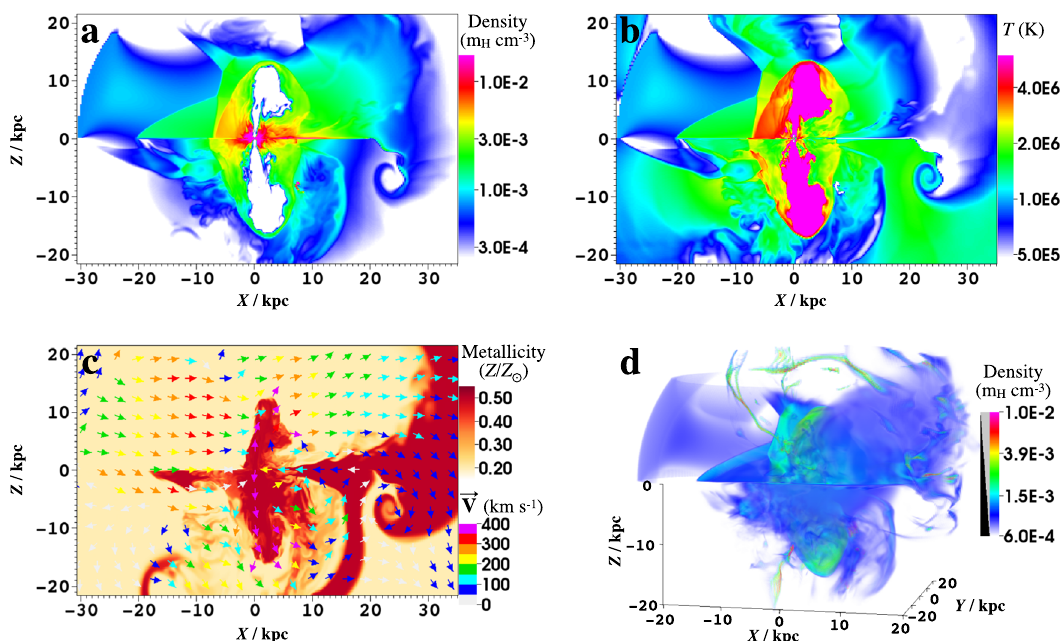
t =360+19Myr(themetallicitiesofboththenuclearout fl owandtheinitialhaloare set to be0.5 Z ⊙ ). Panel d presents a 3Dview of the density distribution. Coordinate values are in units of kpc.